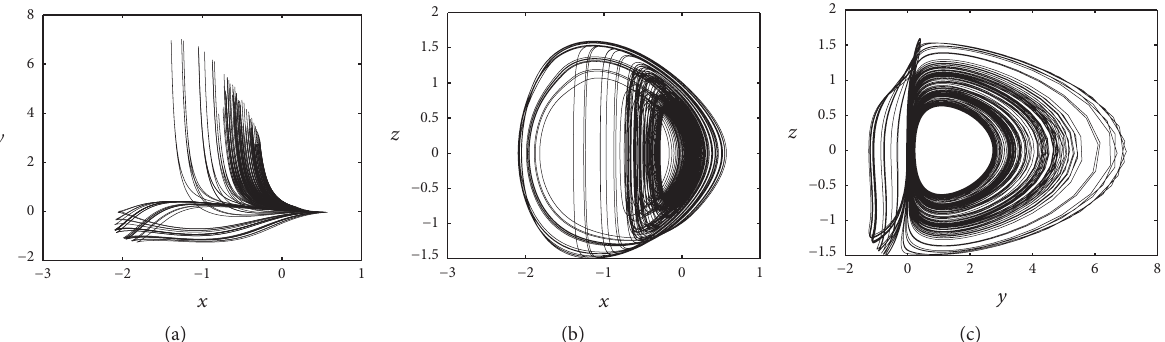
Figure 3: Projections of hidden chaotic attractors with cloud-shaped equilibrium in (a) 𝑥 - 𝑦 plane, (b) 𝑥 - 𝑧 plane, and (c) 𝑦 - 𝑧 plane for 𝑎 = 4 and 𝑏 = 2.5 .